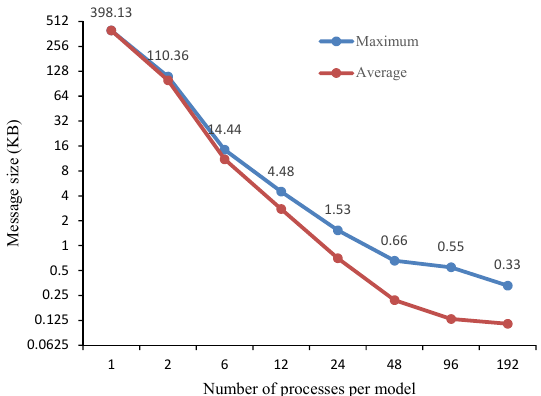
Figure 3. Variation of message size of the P2P implementation ( y axis) in GAMIL2–CLM3 with respect to the number of processes per model ( x axis). The experimental set-up is similar to that shown in Fig. 1.